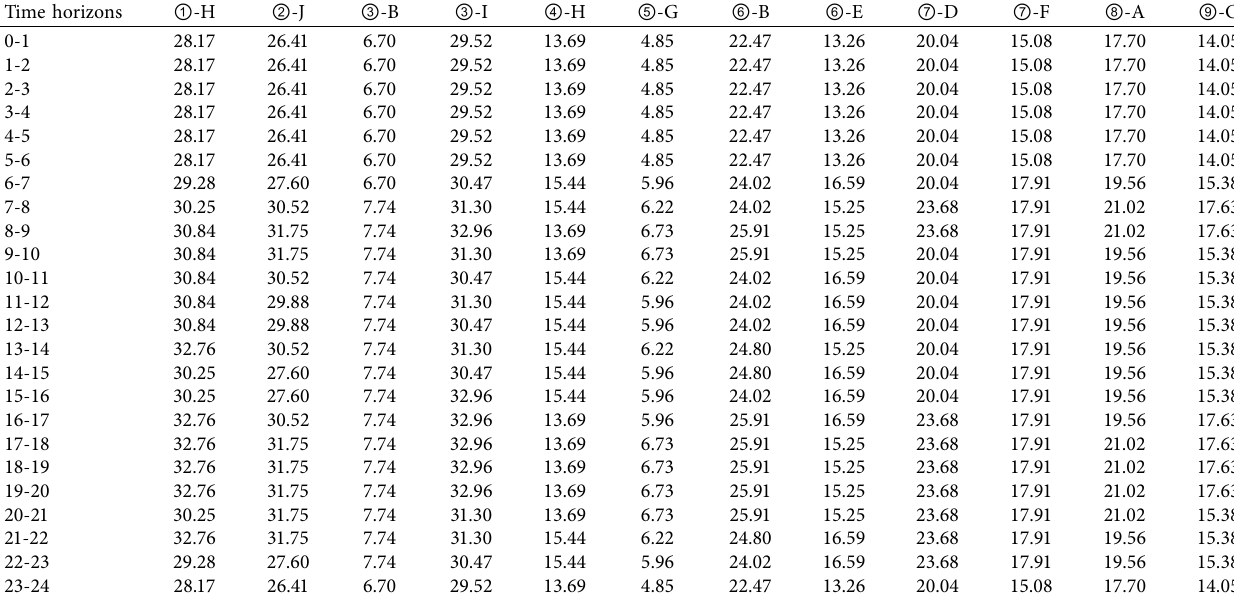
Table 6: The lengths of truck path optimization at different time